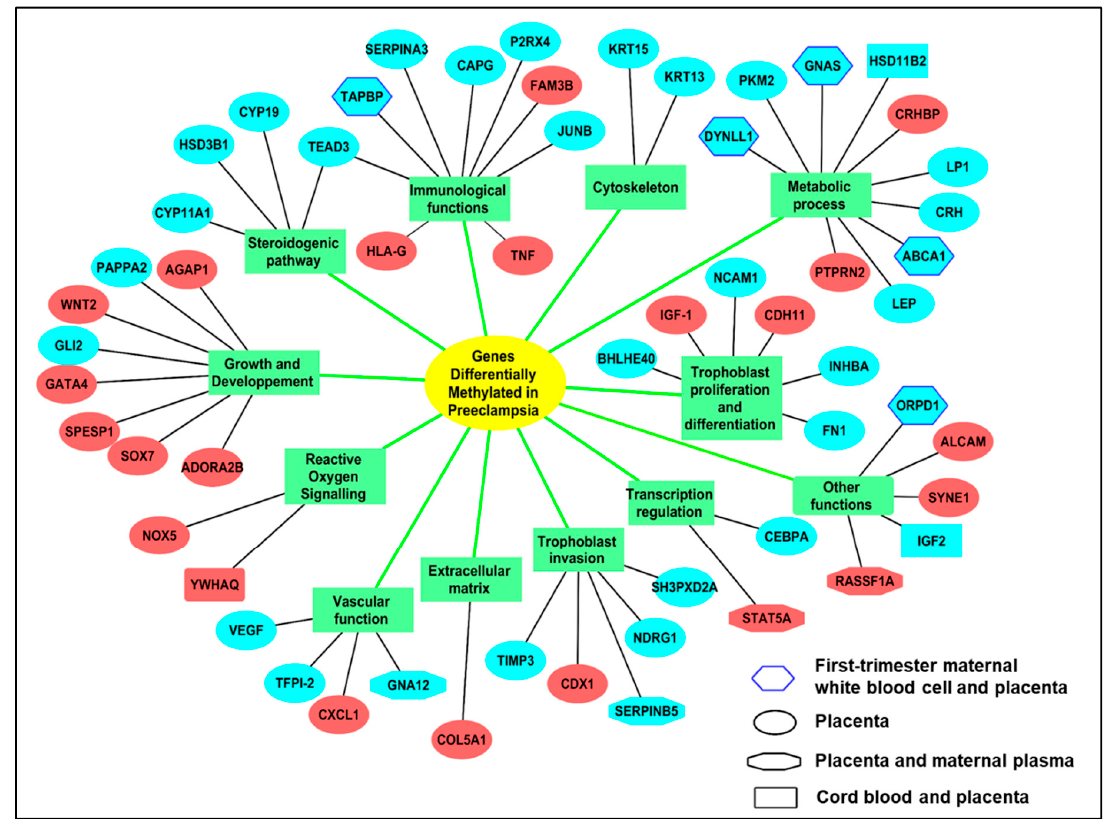
Figure 3. Overview of major methylation alterations in preeclampsia. The main pathways are shown in green boxes. The significant alterations in methylation may be associated either to increased or decreased gene expression (hypermethylated in red and hypomethylated in blue). Table 3. Differentially methylated genes in preeclampsia.